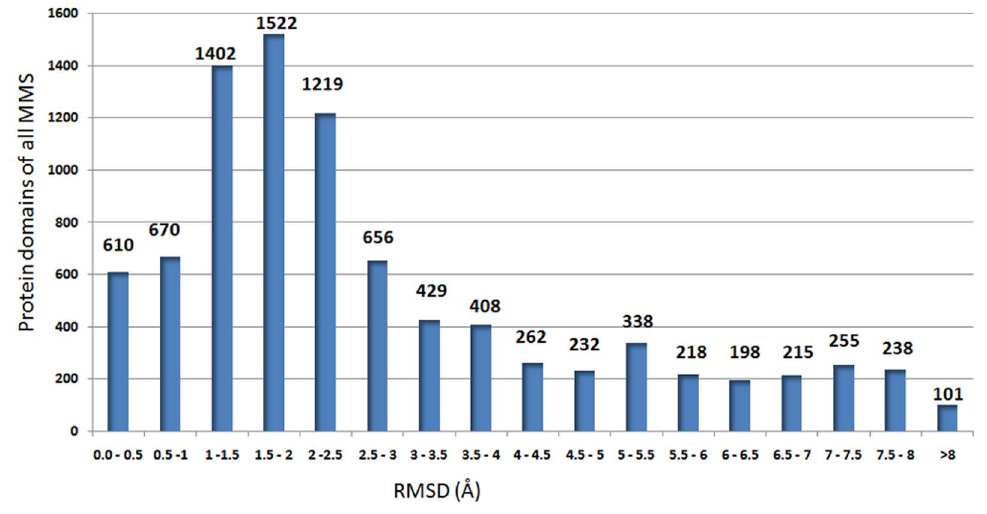
Figure 2. Mean RMSD plot for 8973 members of 731 multi-membered superfamilies. Outlier protein domains are with RMSD greater than 5.5 A˚. (Please see Methods definition of structure deviants).